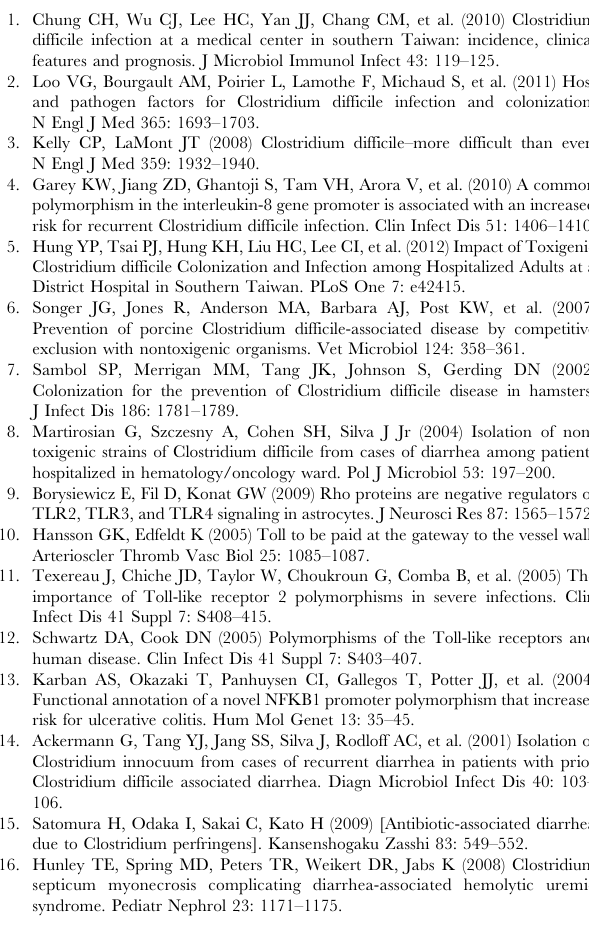
Table S1 Probe sequences used for detecting TLR2, TLR4 and NF- k B